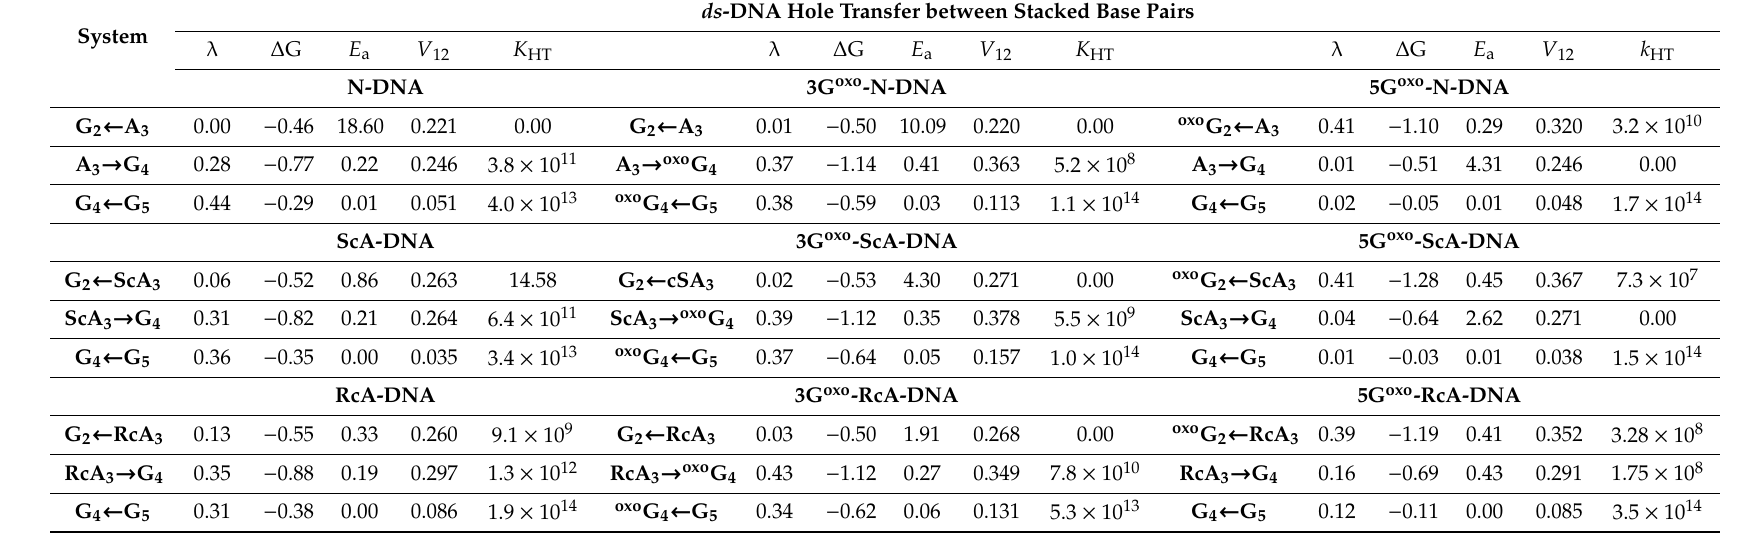
Table 10. Nuclear relaxation energy λ [eV] and hole transfer rate constant k HT [s − 1 ], energy barrier ∆ G [eV], activation energy E a [eV], and electron coupling energies V 12 [eV] of hole transfer between base pairs, calculated at the M062x / 6-31 + G** level of theory in the aqueous phase ([42] and references cited